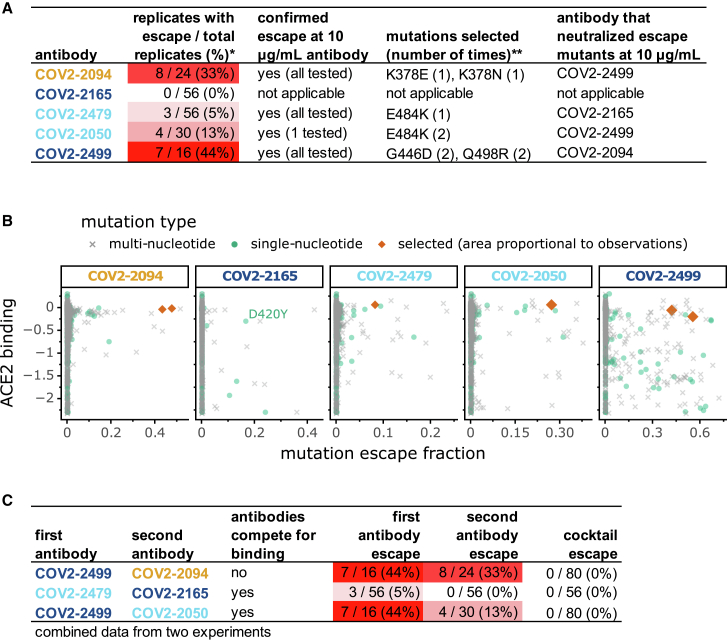
Viral Escape Mutant Selections with Individual Antibodies and Antibody Cocktails(A) Results of viral selections with five individual monoclonal antibodies. The number of replicates where escape variants were selected are indicated, color-coded according to whether escape was selected frequently (red) or rarely (white). Mutations present in the RBD of the selected escape variants are indicated.(B) Each point represents a different amino-acid mutation to the RBD, with the x axis indicating how strongly the mutation ablates antibody binding in our escape maps and the y axis indicating how the mutation affects ACE2 binding (negative values indicate impaired ACE2 binding). All selected mutations were accessible by single-nucleotide changes. The only accessible escape mutation from COV2-2165 that is not deleterious to ACE2 binding is D420Y, but this mutation is highly deleterious for RBD expression (Figure 5B; Figure S5).(C) Results of viral selections with antibody cocktails, indicating the number of replicates with escape out of the total tested. The data for the single antibodies are repeated from (A). In all panels, antibody names are colored according to where in the RBD the majority of their sites of escape fall: orange for the core RBD, light blue for the RBM, and dark blue for ACE2 contact residues. See also Figure S6.